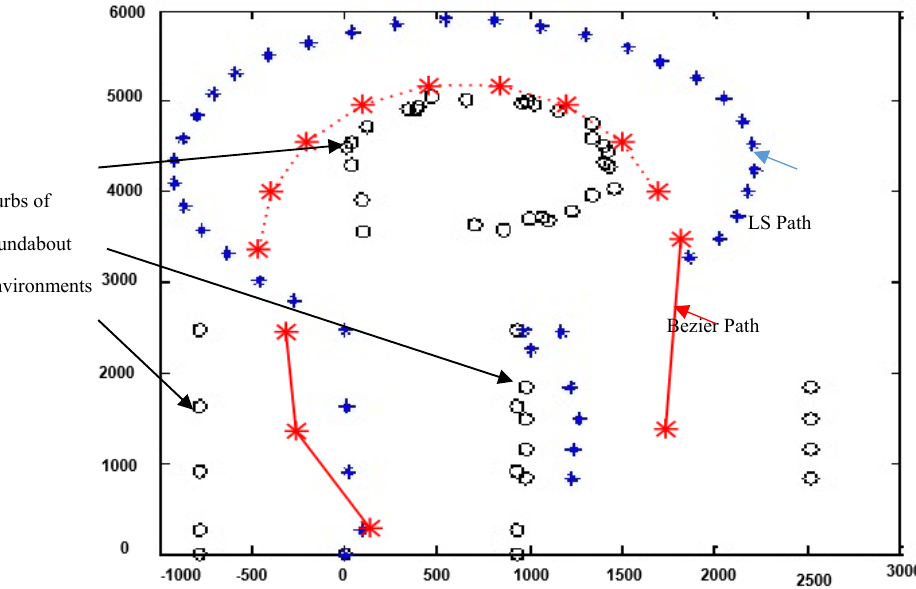
Figure 27. A comparison between Bezier roundabout navigation approach presented in Perez et al. [25] (red *) and the proposed roundabout navigation algorithm in this paper (blue).